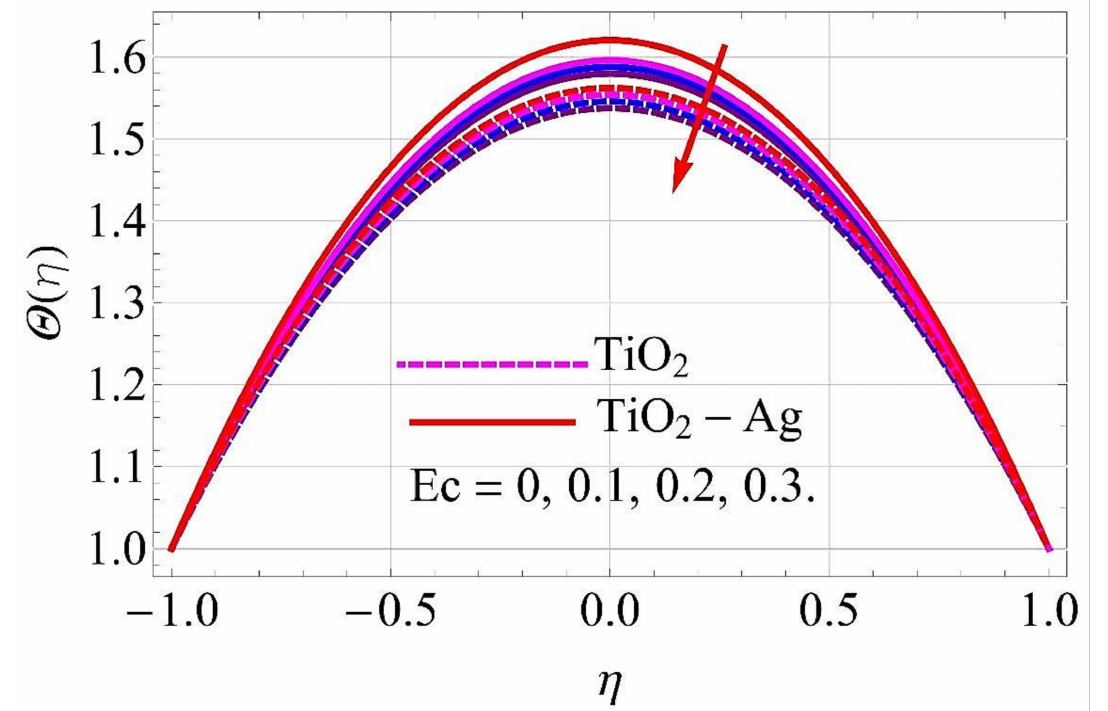
Figure 19. Temperature versus Ec with α = − 5 ◦ for converging/stretching circumstances. When Re = 25, φ 1 = φ 2 = 0.01, Rd = 0.4, Q = Ha = k ∗ = Fr = K 1 = 0.1.